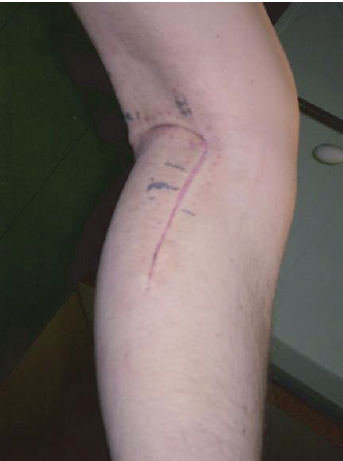
Figure 2: The posterior approach used for index operation (curet- tage and bone cement application) on left leg.